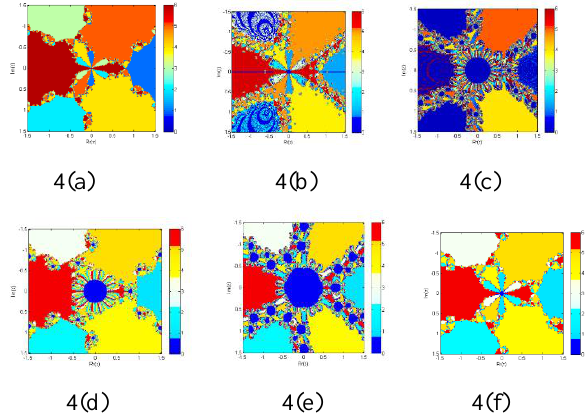
Fig. 4. (a-f), shows the basins of attraction of methods MS1- MS3, KM, CM and JM) respectively for non-linear function f_4 (s)=s^6-s^3-1 having roots